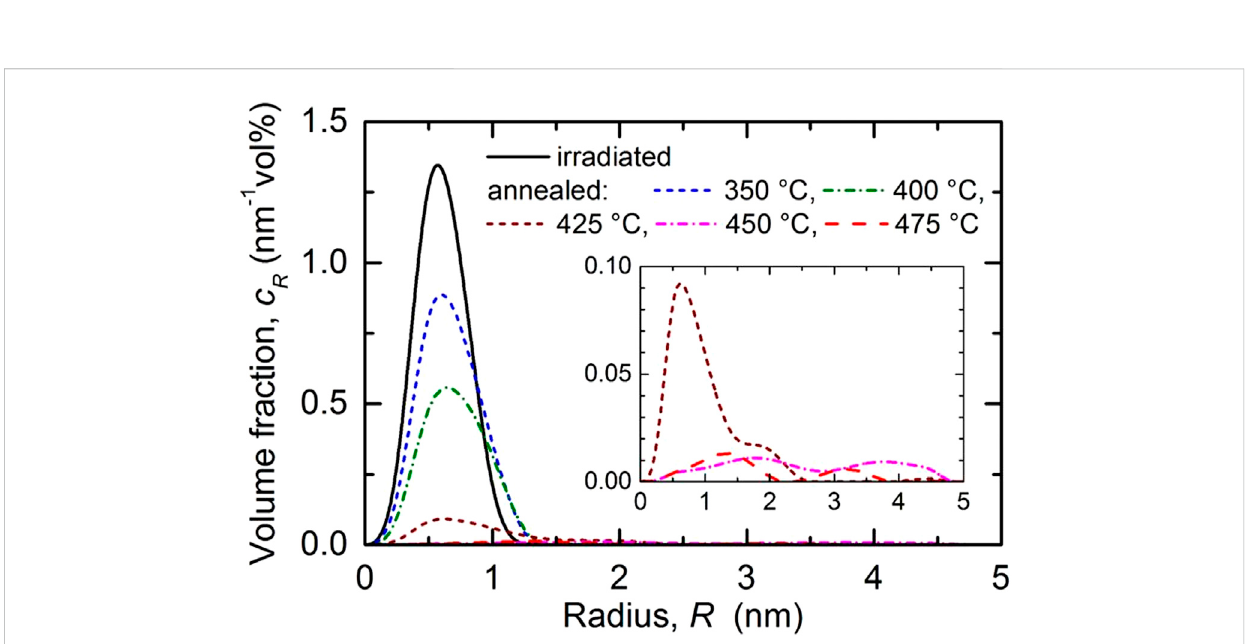
FIGURE 5 Size distribution of the irradiation-induced scatterers in terms of volume fraction per size increment for the as-irradiated condition of the weld and size distributions of the remaining scatterers after post-irradiation annealing. For the three highest annealing temperatures see